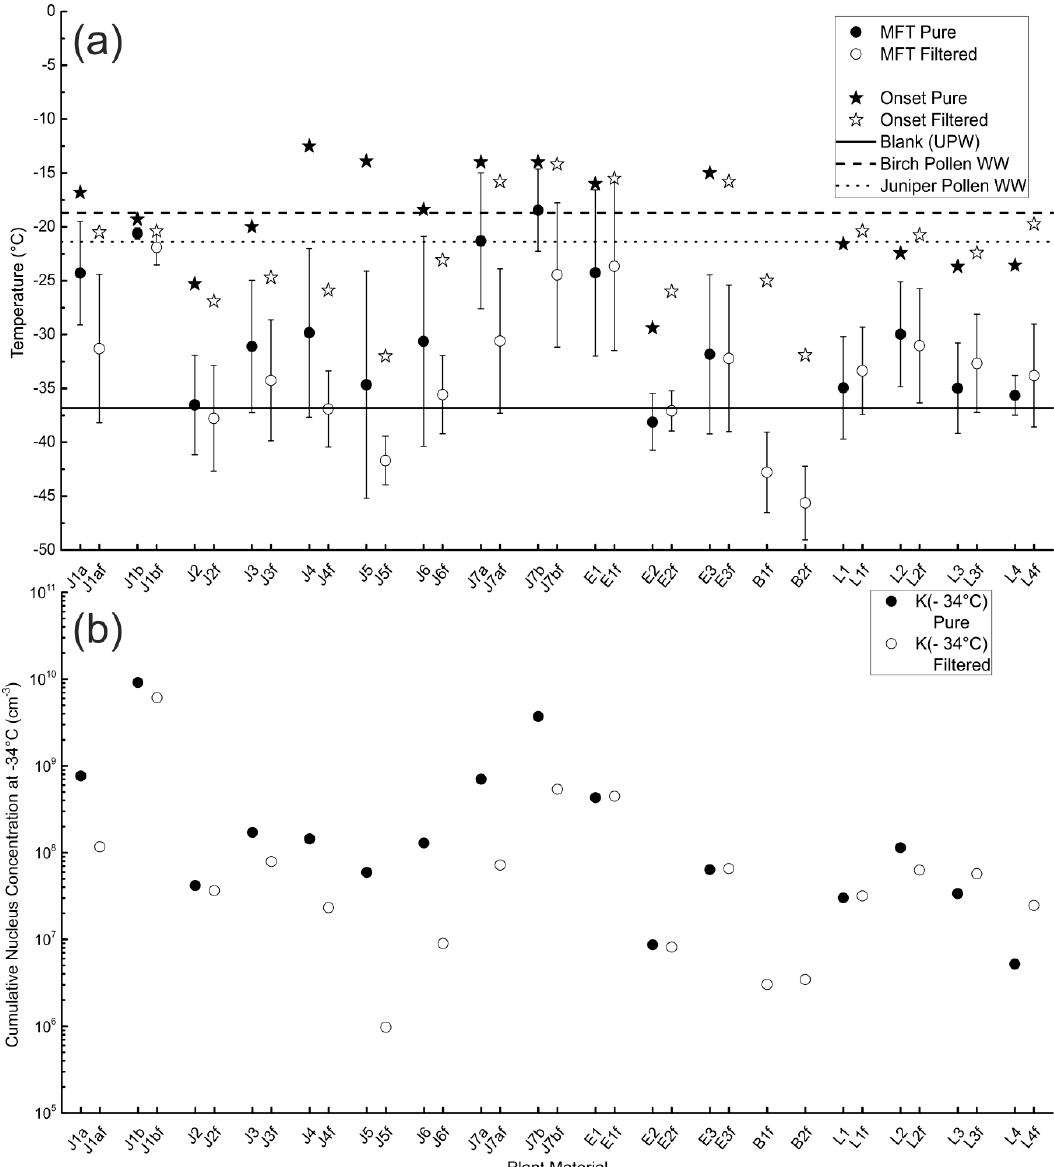
Figure 2. ( a ): MFT (circles) and onset temperature (stars) of the analyzed juices (black currant (J1), blueberry (J2), chokeberry (J3), cranberry (J4), lingonberry (J5), sambuccus (J6), sea buckthorn (J7)), dried berry extracts (juniper berries (E1), rowanberries (E2), sea buckthorn (E3)), frozen berries (blueberry (B1) and Raspberry (B2)) and leaf extracts ((L1) blueberry, (L2) juniper, (L3) raspberry, (L4) sea buckthorn). Samples marked with an f are filtered (particles < 0.2 µ m in diameter) and are displayed as hollow symbols; filled symbols correspond to unfiltered samples. MFTs are given with the respective standard deviation as error bar. The graph contains three lines: the dashed line refers to the mean freezing temperature of birch pollen washing water ( − 18.7 ◦ C), the dotted line to juniper pollen washing water ( − 21.4 ◦ C, extracted from Pummer et al. [51]), and the solid line refers to the MFT of ultrapure water (UPW) measured with our setup during the measurement series ( − 36.8 ◦ C). ( b ): The cumulative nucleus concentration at − 34 ◦ C (K( − 34 ◦ C)). Again, filtered samples are marked with an f and hollow symbols, while unfiltered samples are represented by filled